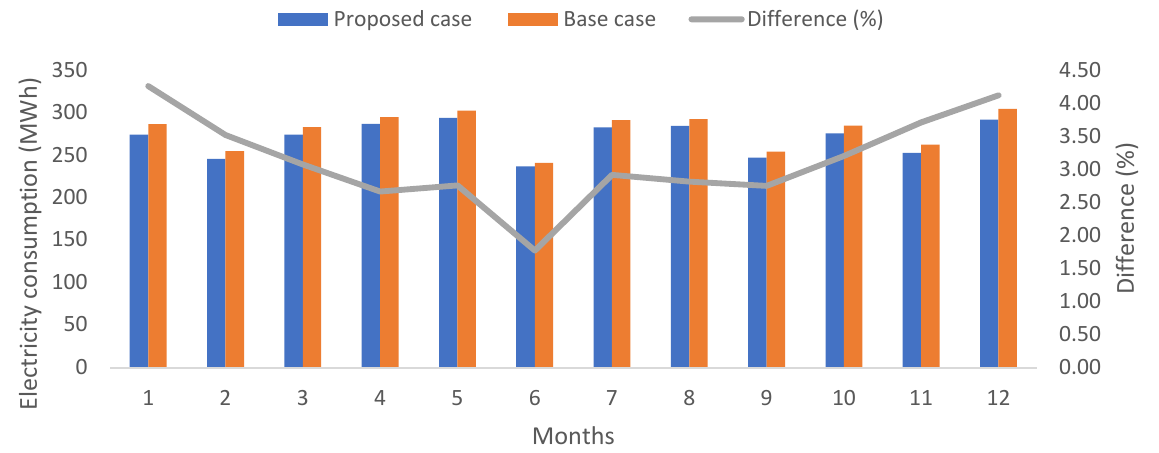
Figure 13. Comparison of monthly roof-ceiling heat gains for the urban zone, during occupied hours. Own elaboration.